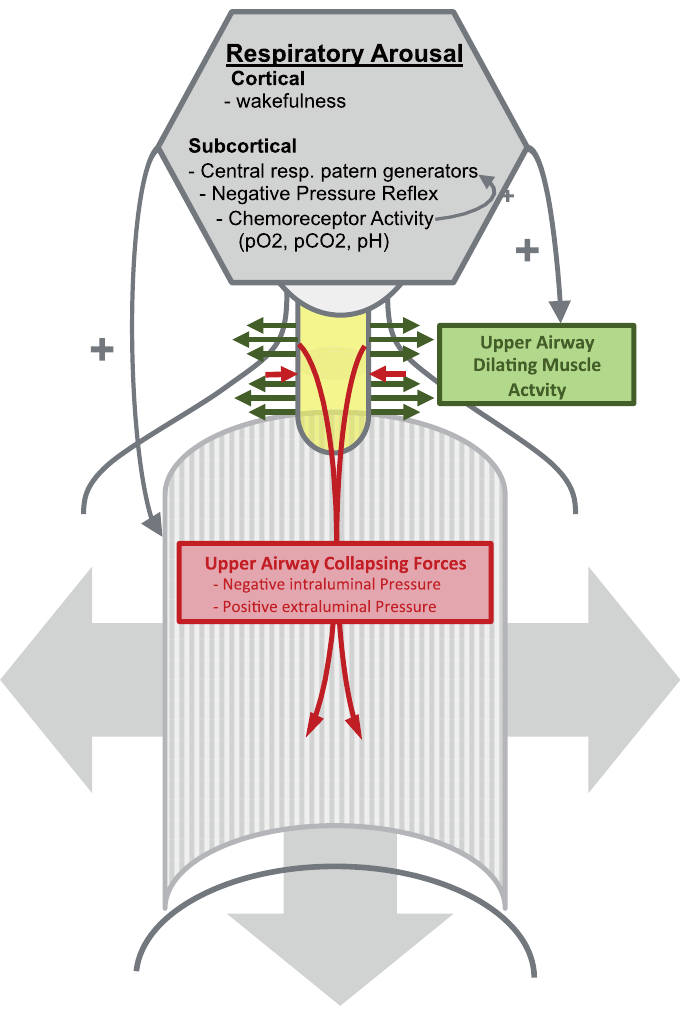
Figure 1. Perioperative upper airway patency. Respiratory arousal (grey hexagon) consisting of cortically and subcortically generated excitatory activity increases airway dilator muscle activity, thereby increasing upper airway dilating forces (green arrows). This counteracts the upper airway constricting forces (red arrows) generated by surrounding tissue pressure and negative intraluminal pressure during inspiration. (UA=upper airway